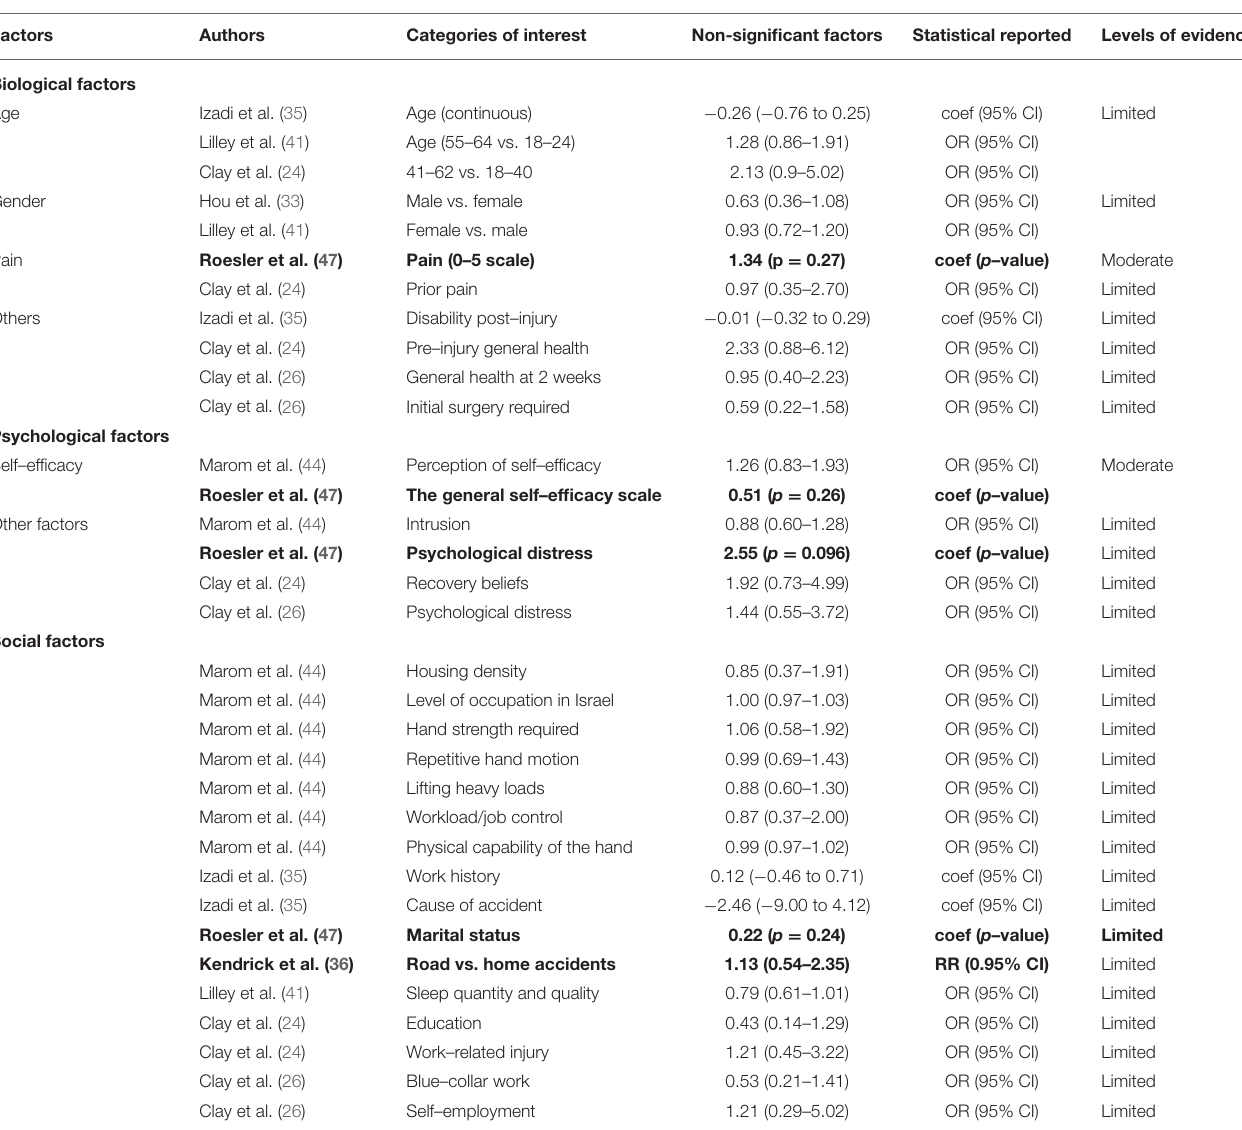
TABLE 5 | Non-significant factors for RTW in the early phase ( ≤ 6 months) postinjury.